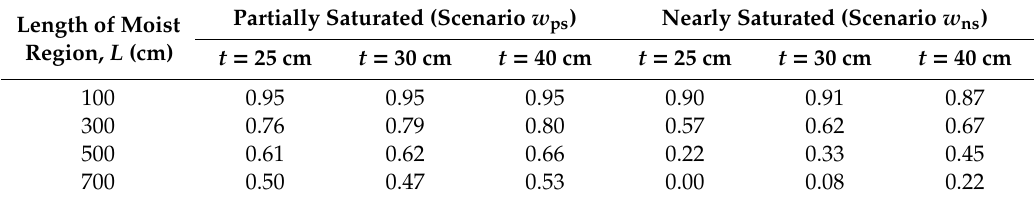
Table 3. Out-of-plane lateral strength reduction ratio ( R